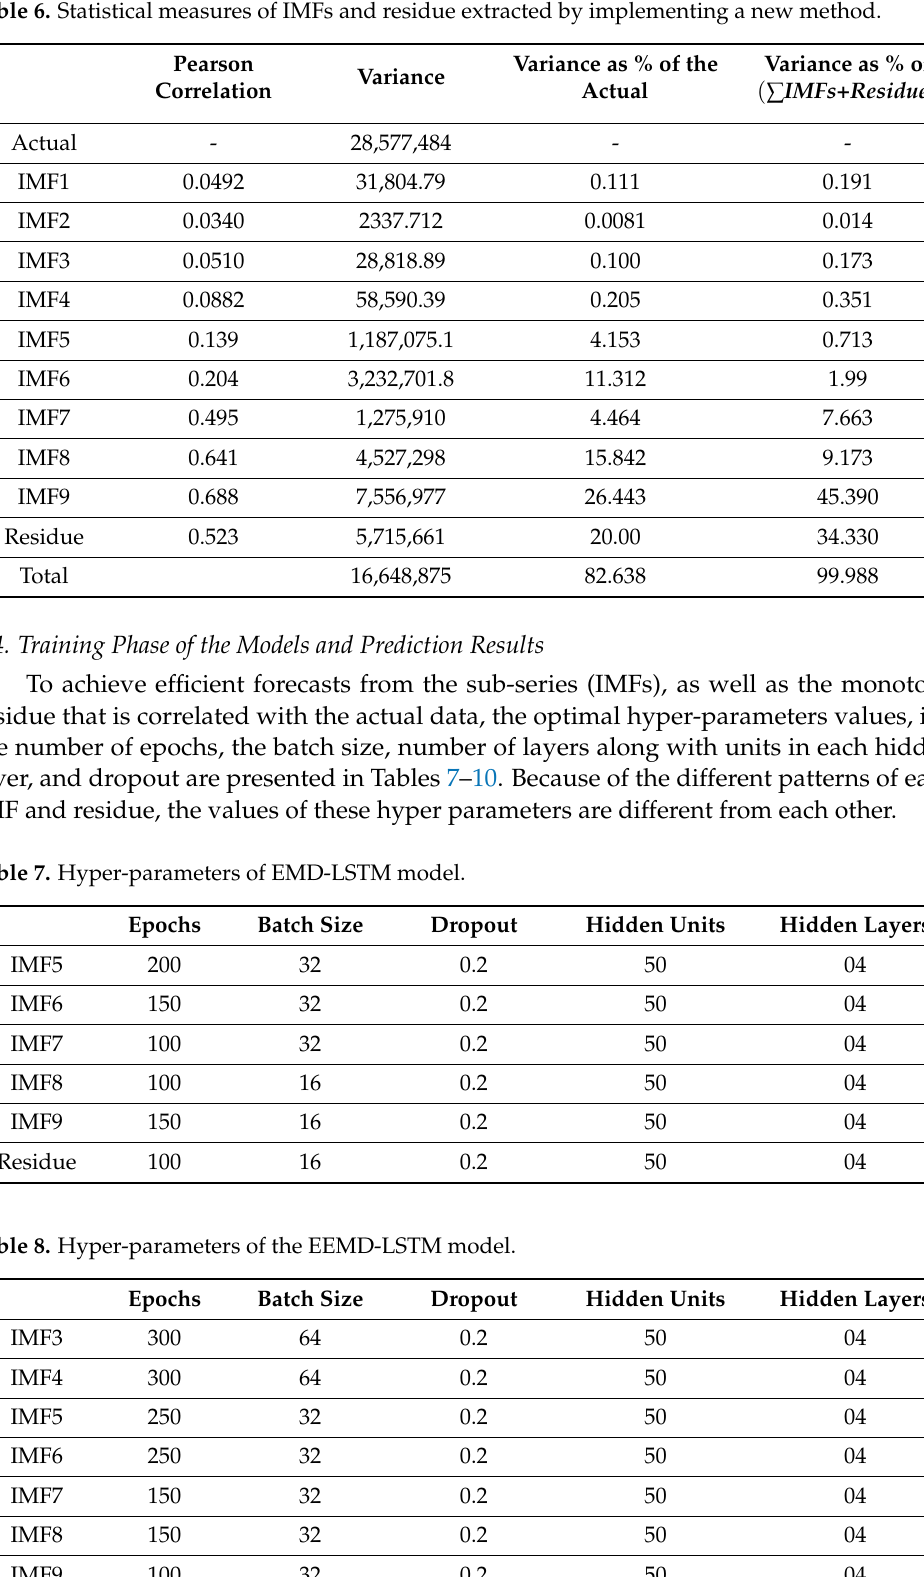
Table 6. Statistical measures of IMFs and residue extracted by implementing a new method.